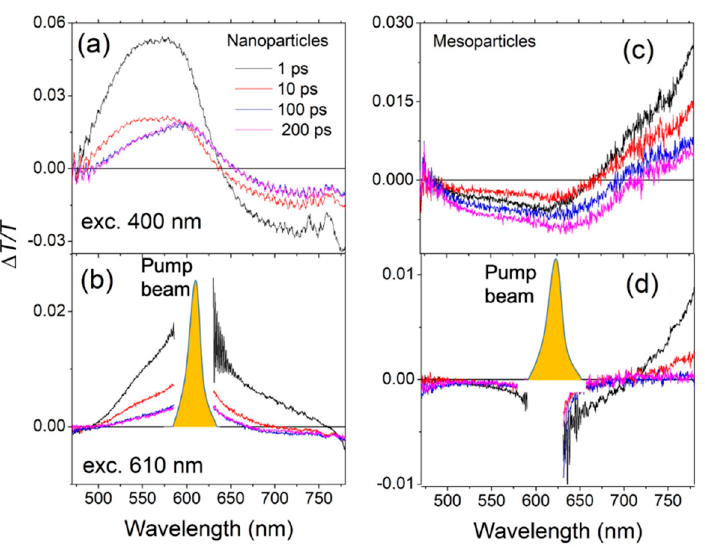
Figure 3. Transient absorption spectra at different probe delays for nanoparticle ( a , b ), and mesoparticle ( c , d ), films at two different wavelengths of pump excitation: 400 nm ( a , c ) and 610 nm ( b , d ). The ordinates for all axes are ∆ T / T and the abscissae are wavelength.